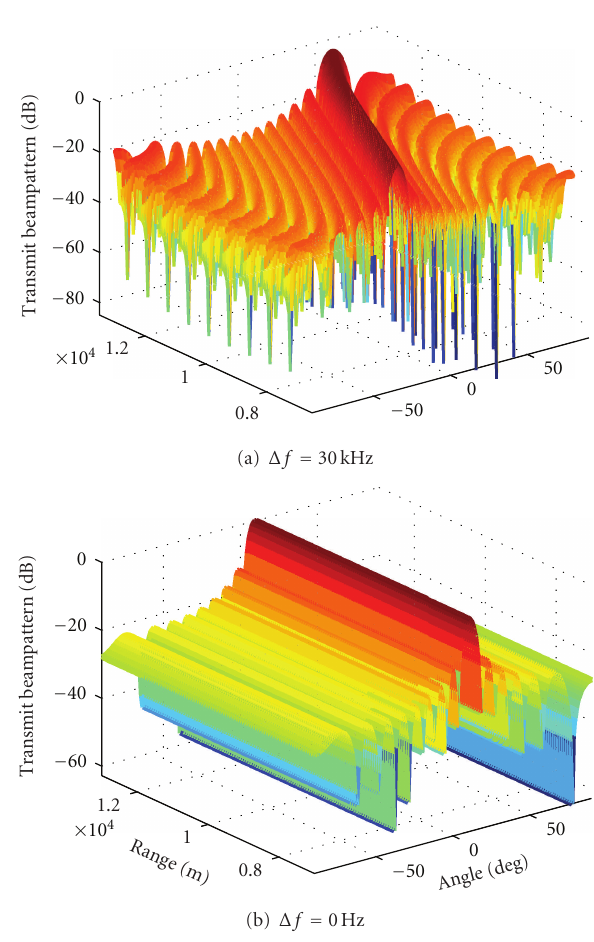
Figure 7: The comparative transmit beampattern when L = 0 . 5 λ .